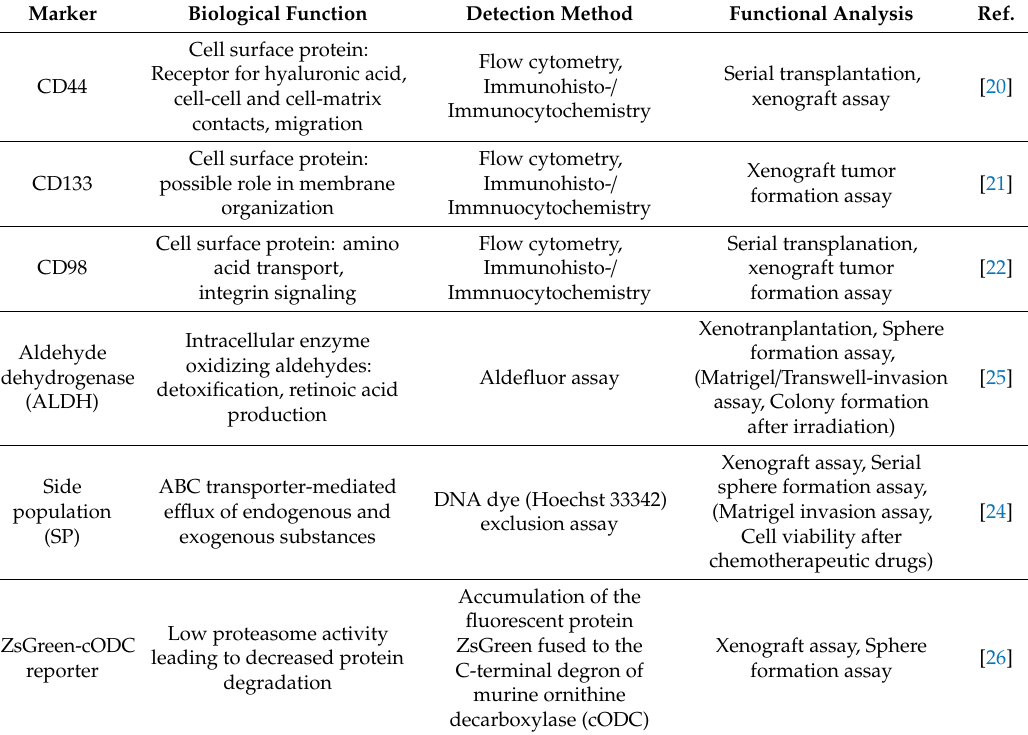
Table 1. Biological role and functional analysis of the HNSCC CSC